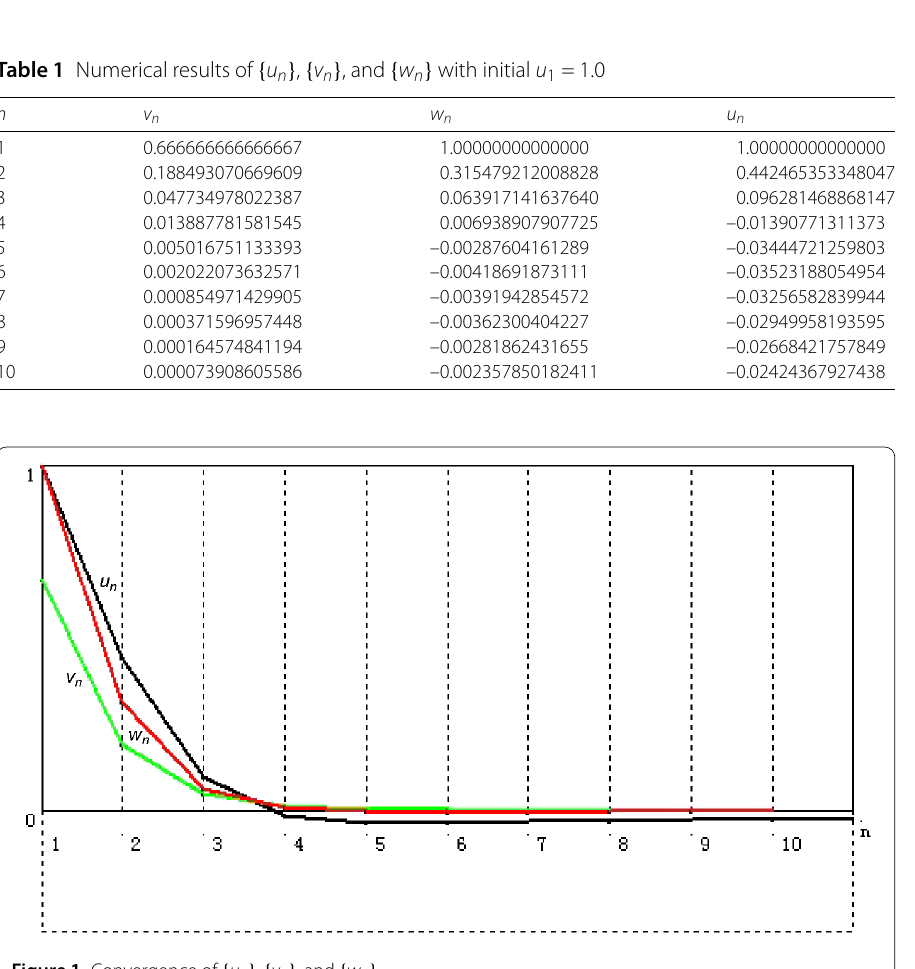
Figure 1 Convergence of { u n } , { v n } , and { w n